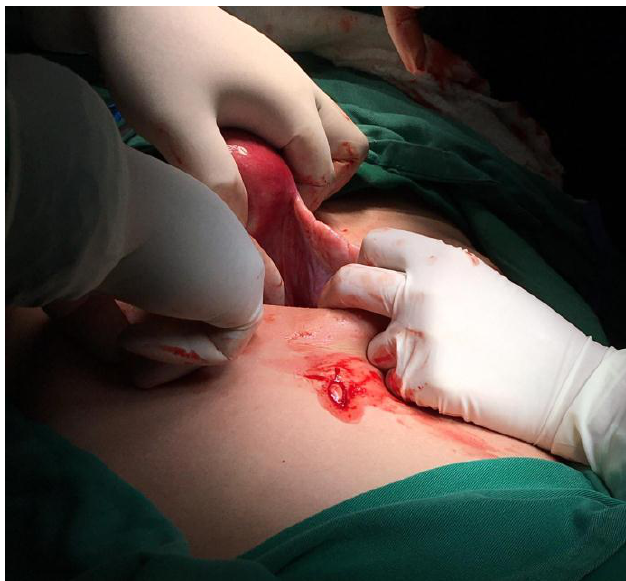
Figure 3 : the functional non-communicating rudimentary horn in the laparotomy.